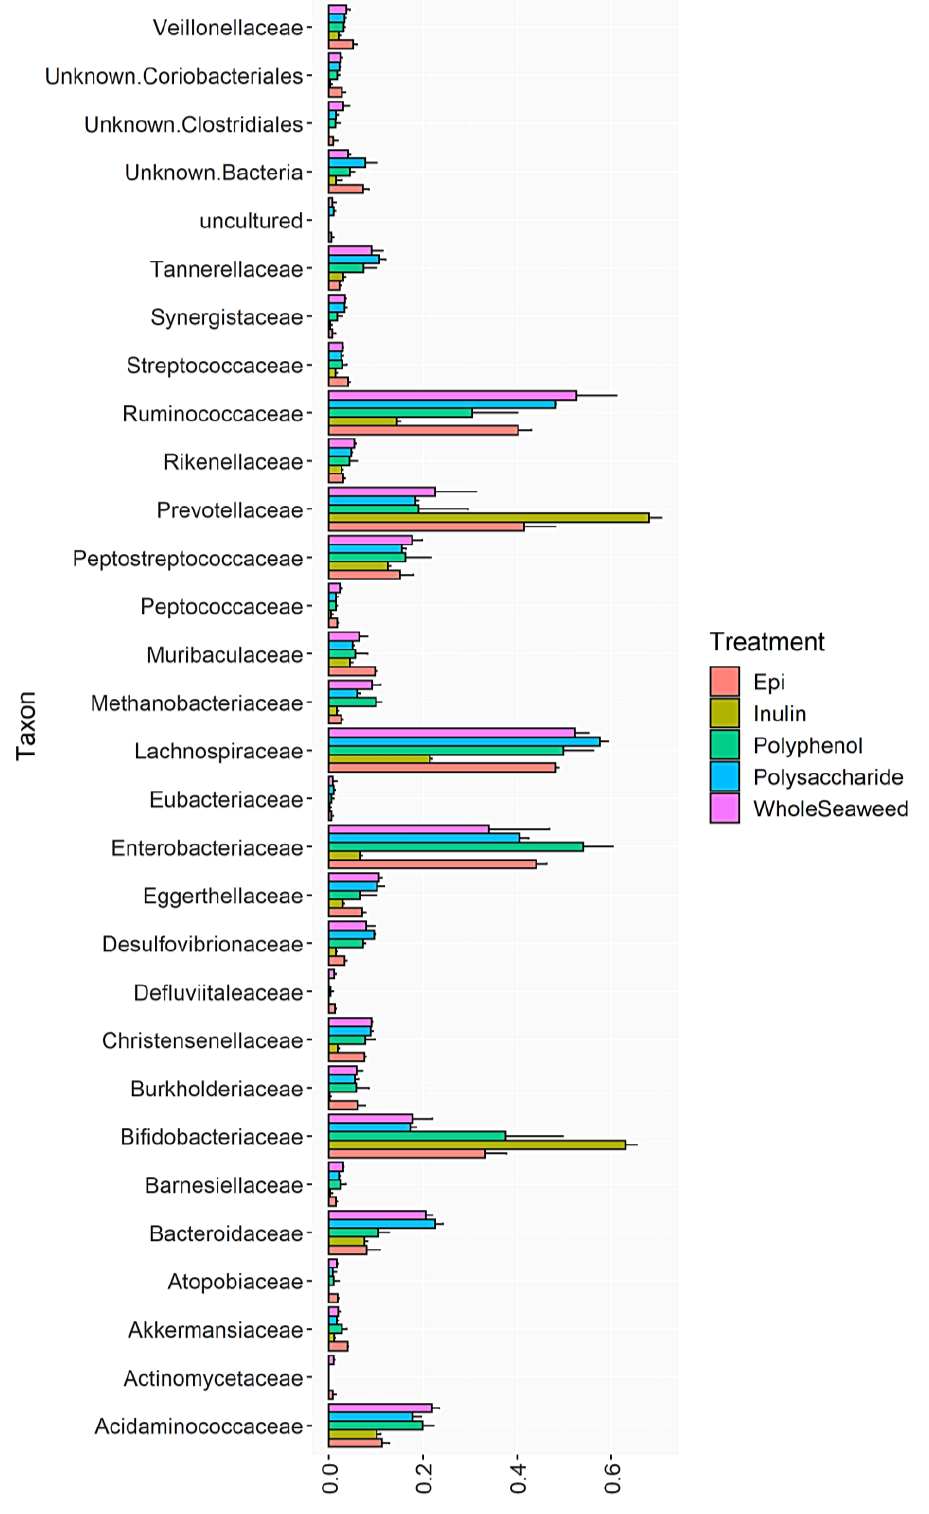
Figure 2. Relative abundance of bacterial families after 24 h fermentation with E. radiata WH, PS, PP, INU or EGCG.